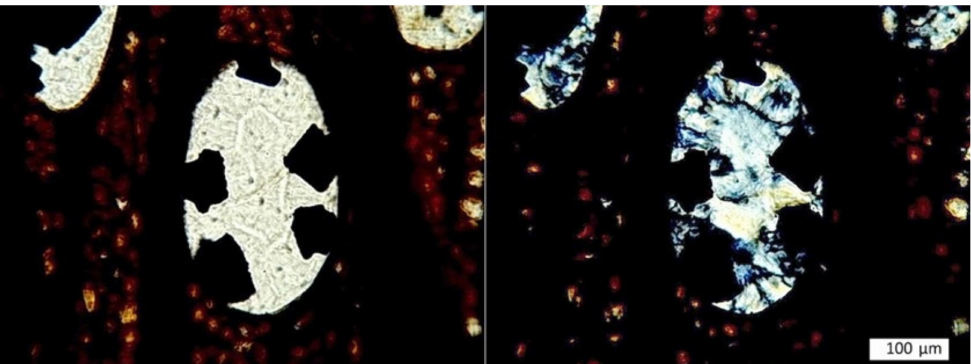
Figure 38. Opalized Miocene wood from Georgia nation contains pyrite crystals that are attached to the vessel walls, which subsequently became filled with chalcedony. Specimen provided by Mirian